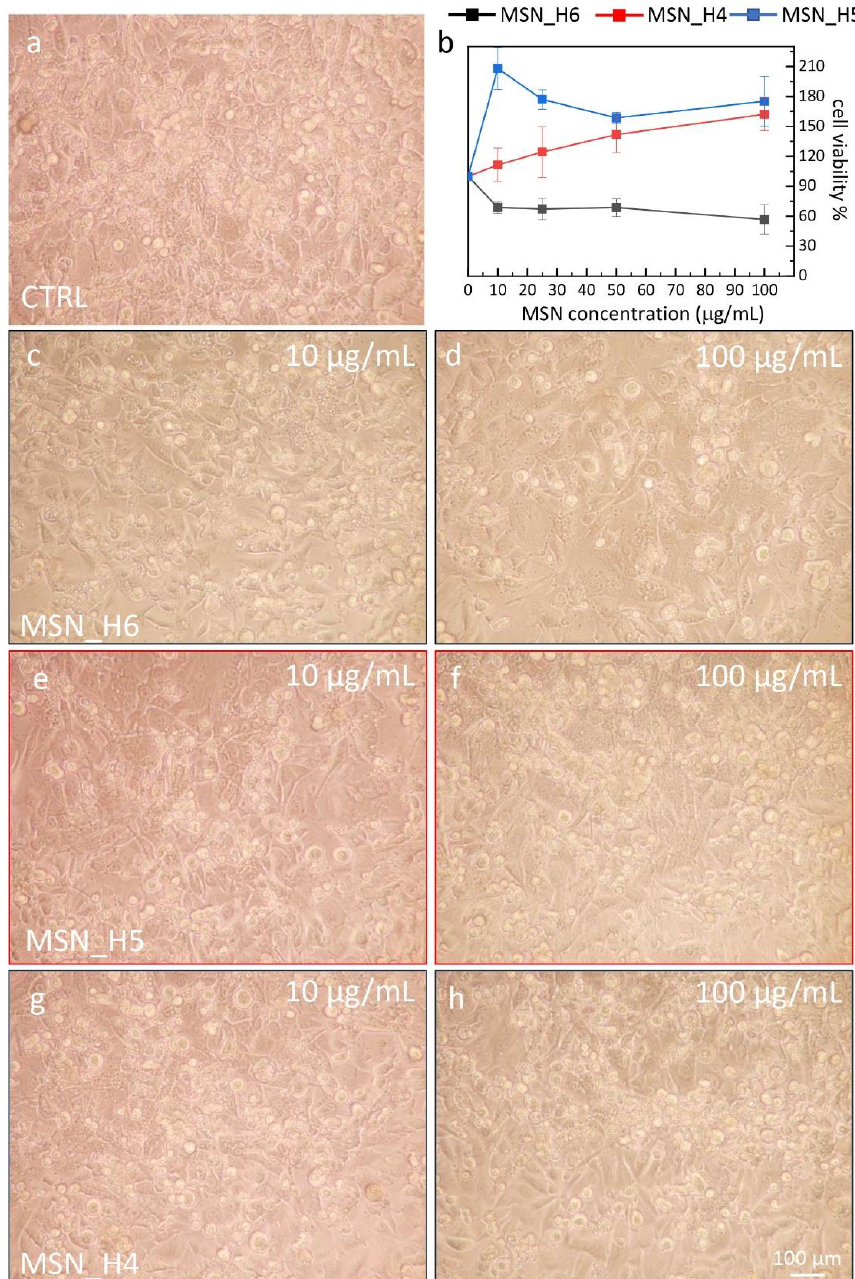
Figure 6. ( a , c – h ) Representative phase contrast optical images showing the morphology of bEnd.3 (20 × magnification) and of the control (CTRL, 100%) after 24 h treatment with the MSN samples, as labeled, prepared by the homogenous solution approaches, at the indicated concentrations. ( b ) Graph of the cell viability, determined by the MTT test, expressed as percentage of surviving cells in comparison with control (CTRL, 100%) represented by untreated bEnd.3 cells in serum-free DMEM.